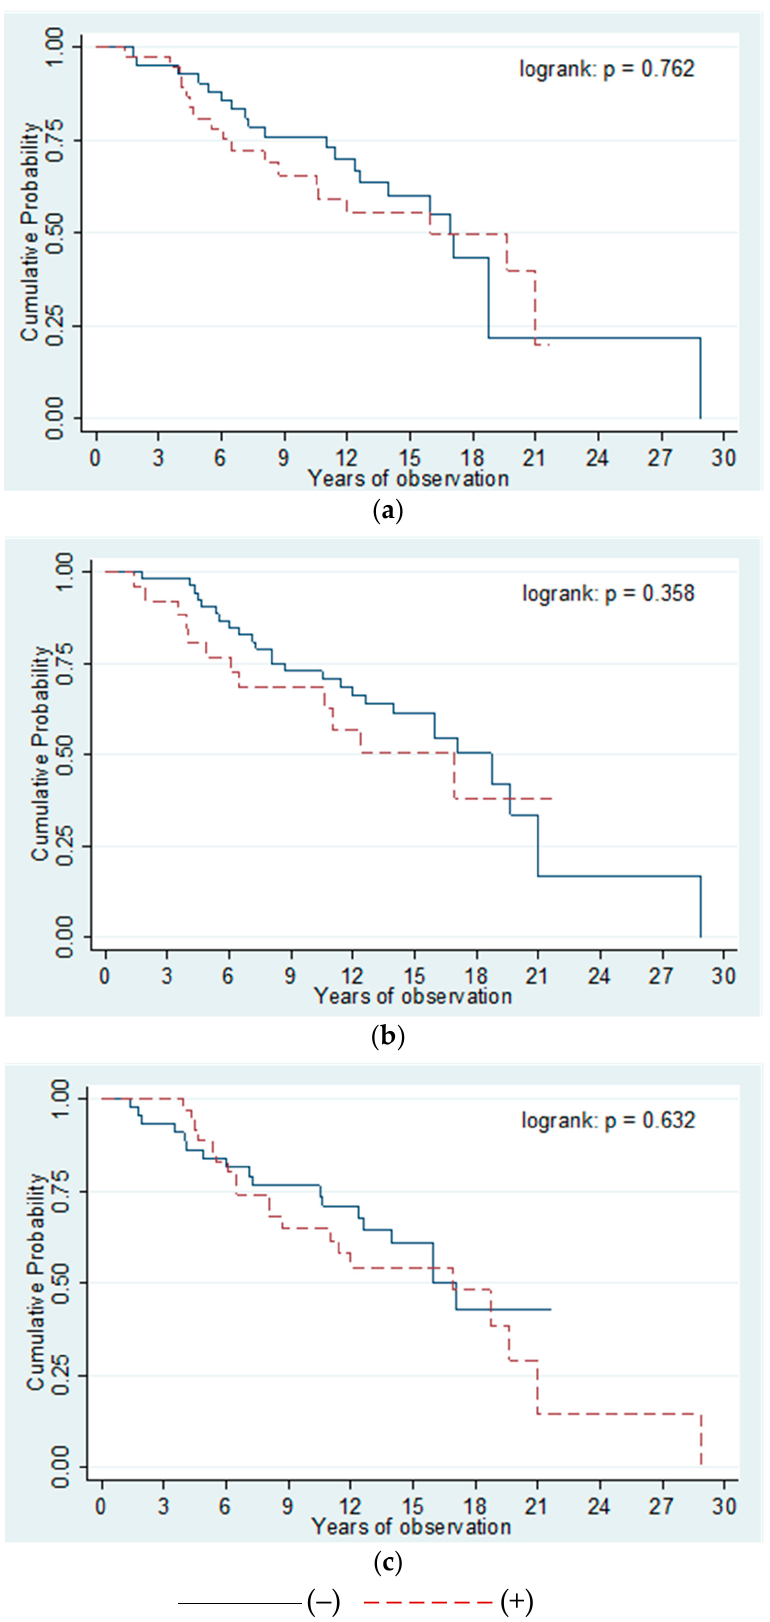
Figure 8. Kaplan–Meier curves demonstrating the survival of patients positive and negative for anti- nuclear envelope antibodies. ( a ) Anti-gp210 antibodies; ( b ) Anti-p62 antibodies; ( c ) Anti-LBR